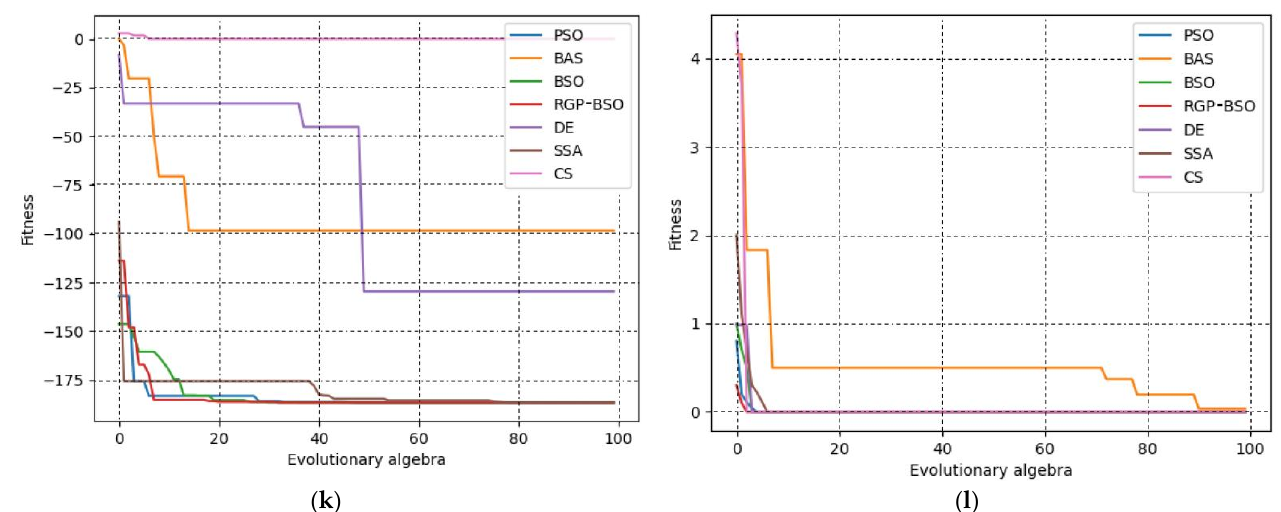
Figure 2. Fitness curve. ( a ) f1 function. ( b ) f2 function. ( c ) f3 function. ( d ) f4 function. ( e ) f5 function. ( f ) f6 function. ( g ) f7 function. ( h ) f8 function. ( i ) f9 function. ( j ) f10 function. ( k ) f11 function. ( l ) f12 function.